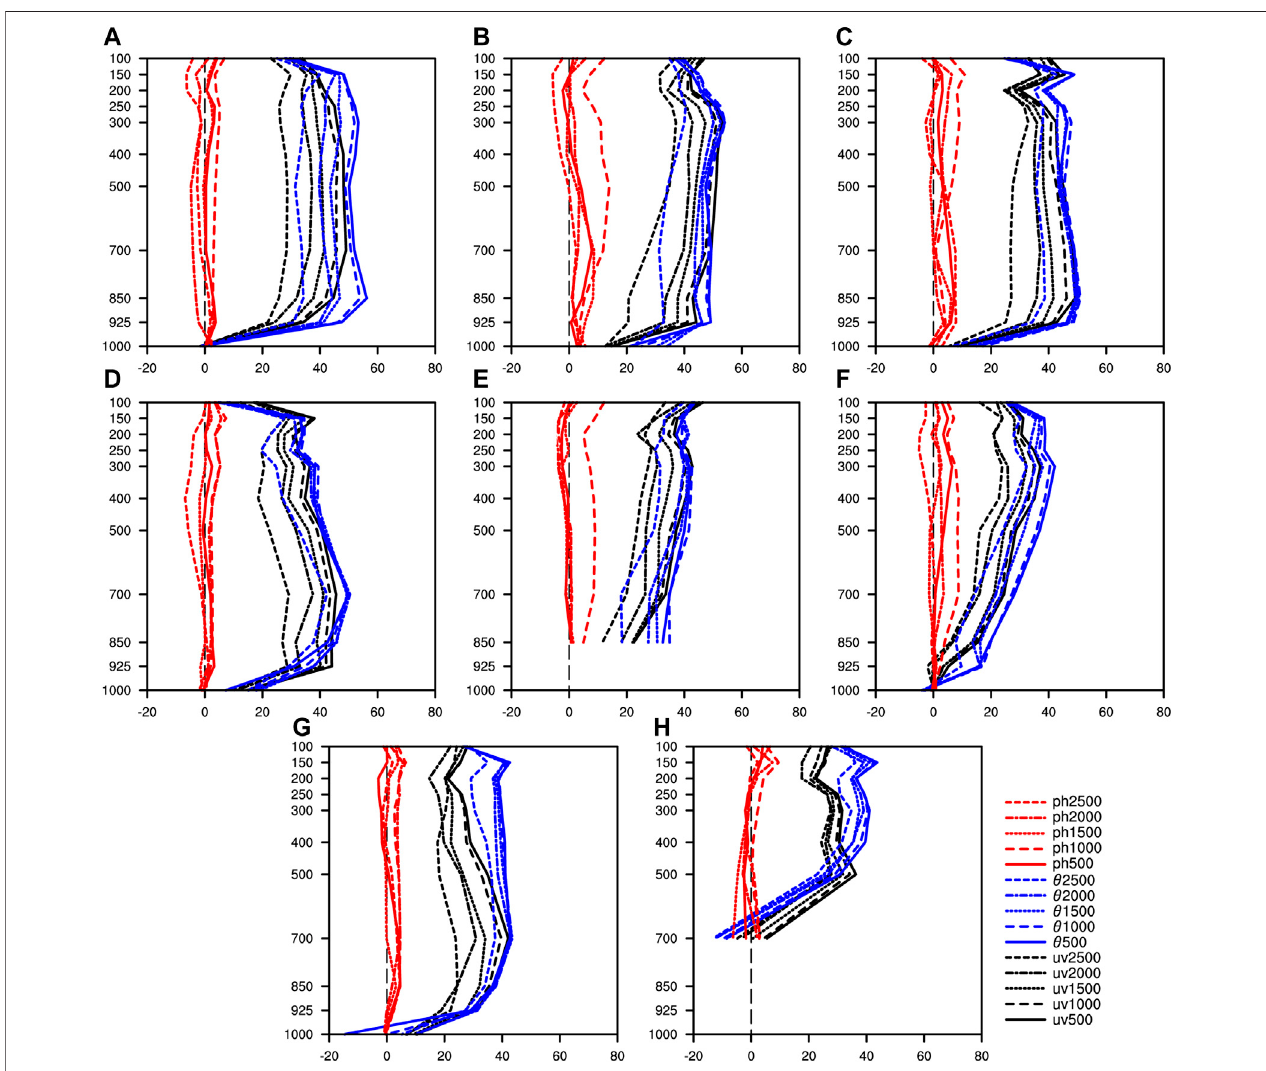
FIGURE6| VariationintheRATE(%)ofsimulatedmeteorological fi eldsatstandardverticallevels(hPa)underdifferentcutoffwavelengths: (A) NortheastChina; (B) North China; (C) East China; (D) South China; (E) East of Northwest China; (F) West of Northwest China; (G) Southwest China; (H) Tibet.